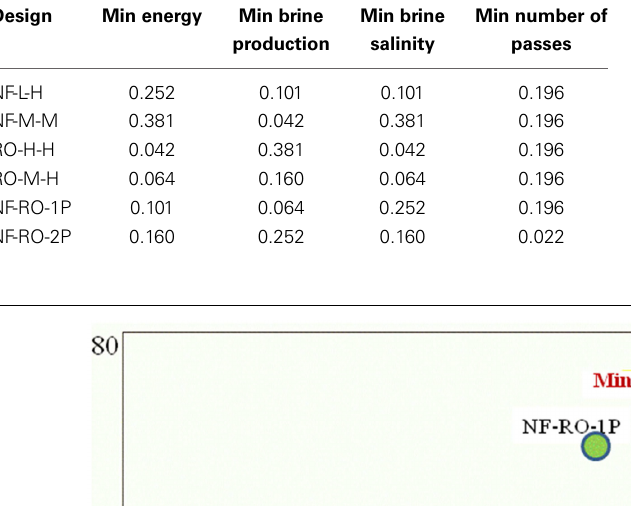
the first pass and ESPA4-MAX membranes at the second pass (code NF-RO-2P). Each variable is represented by an arrow, emerging from the center of gravity of the n points. The direction of each arrow is chosen so that the correlation between the actual values of the variable and their projections on the arrow is maximal. (MDS Statistics: “Coefficient of alienation” = 0.038, “Average of Correlations” = 0.905). The “goodness of fit” measures (concerning the “Coefficient of alienation” and the variables correlations) is satisfied both for the configurations and the